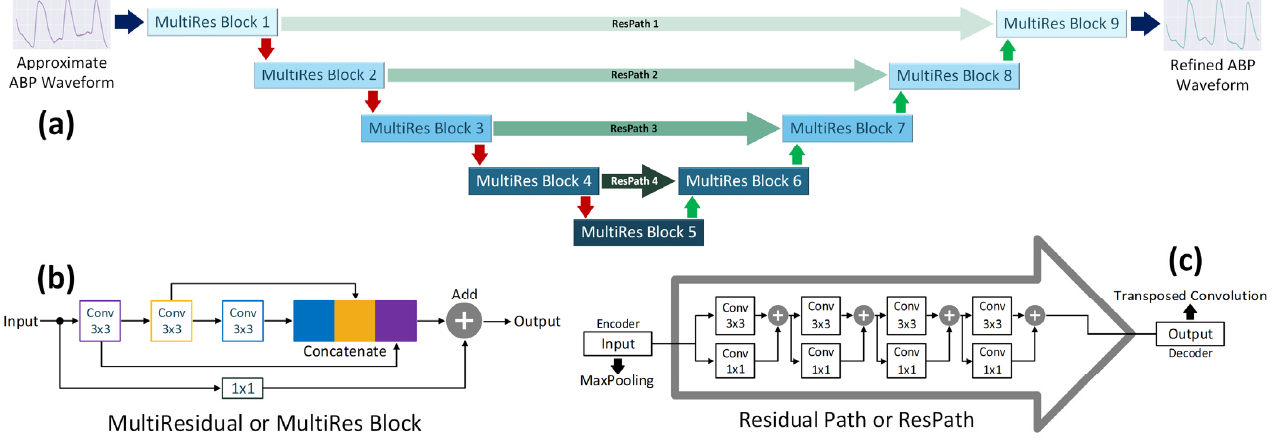
Figure 3. ( a ) Refinement Network. The PPG2ABP pipeline utilizes a 1D-MultiResUNet Network consisting of ( b ) MultiResidual Blocks and ( c ) Residual Paths to refine the approximate waveform constructed by the Approximation Network.